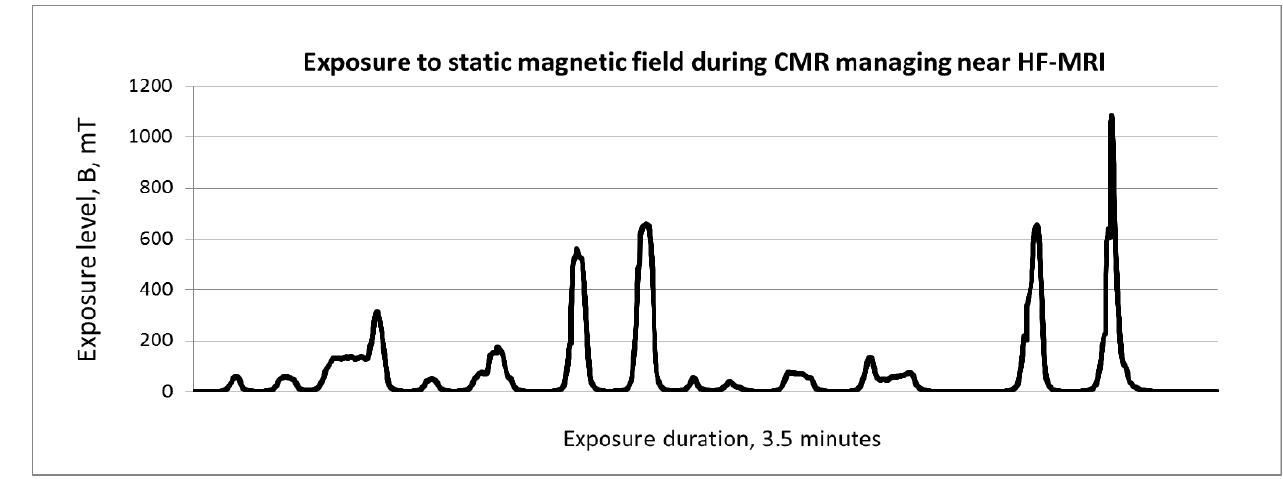
Figure 3. Example of the results of SEmf measurements during a modelled radiographer exposure event (REE) related to CMR in an HF-MRI scanner, managed by an investigator equipped with an exposimeter with a Hall probe located on the chest (C). Note to editors: please find copy of all figures in enclosed files, please keep the caption together with the figure on the same page.